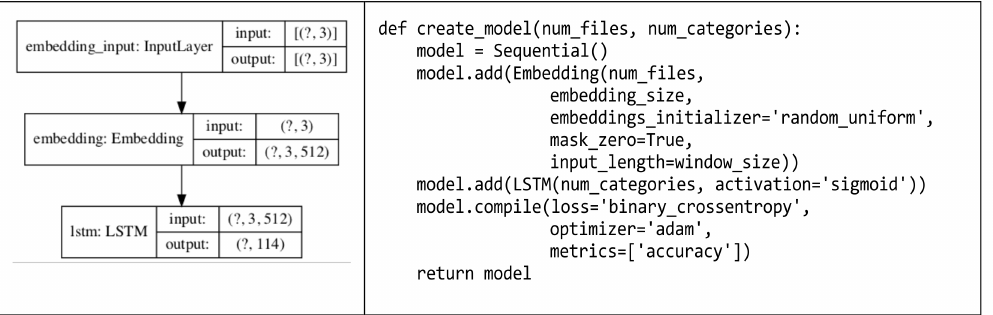
Figure 8. CERNN model for the learning